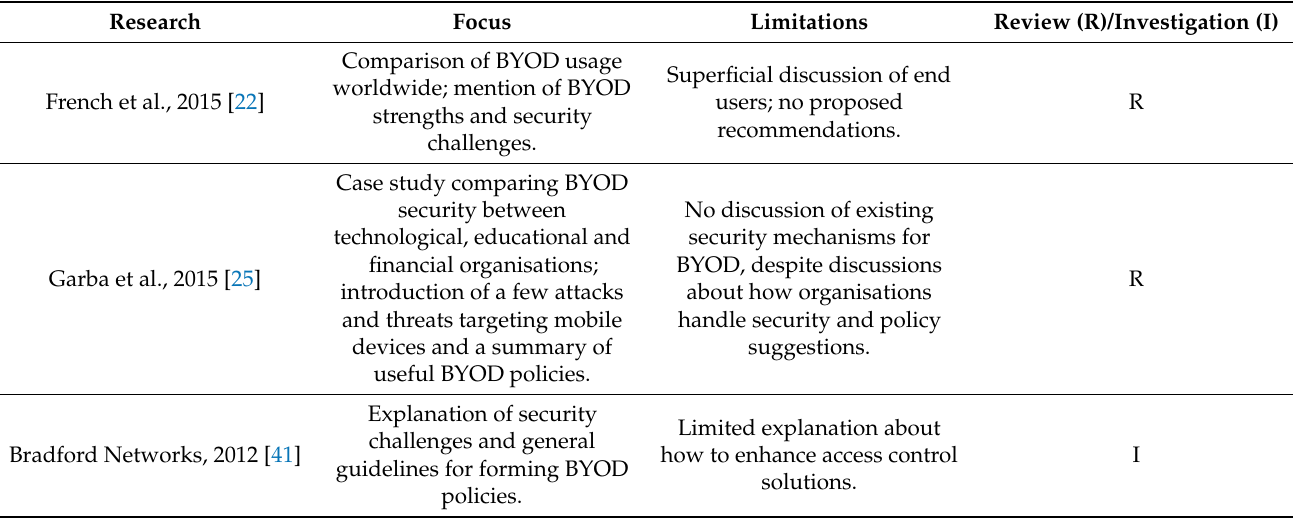
Table 1. Focus and limitations of some of the key older (pre-2016)